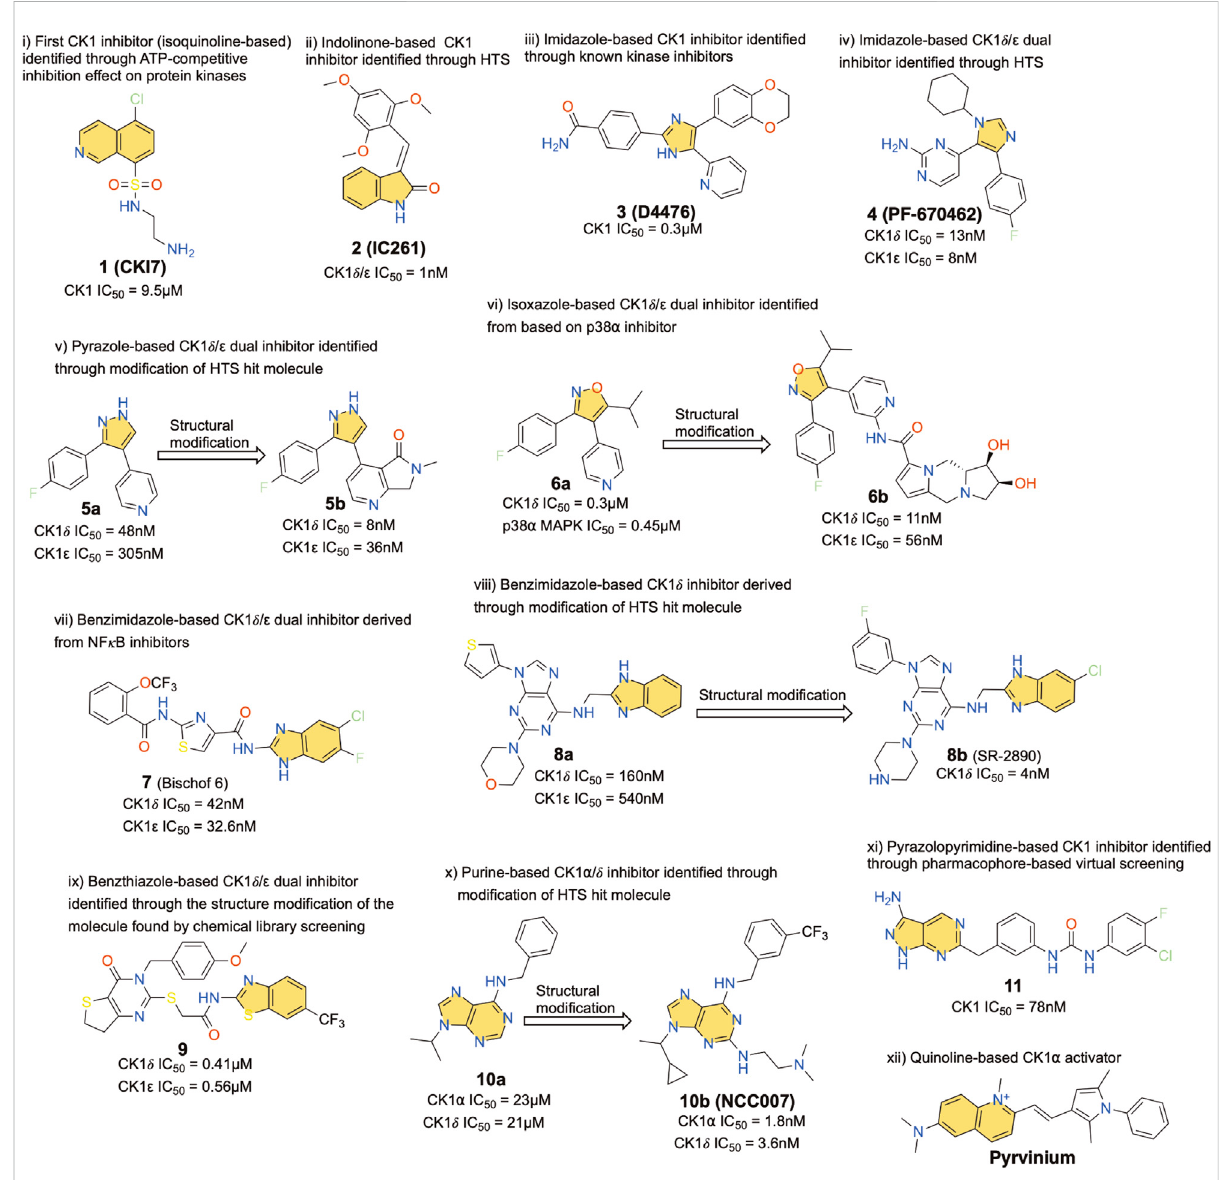
FIGURE 2 Representative chemical structures displaying a kinase inhibitory activity and their potency on CK1 family members. Yellow indicates various priviledged chemo-motifs. Heteroatoms are highlighted with standard